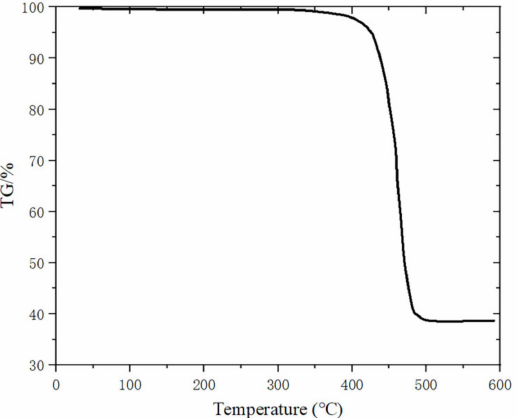
Figure 13. The weight loss rates of PA12/GBs of the outer wall